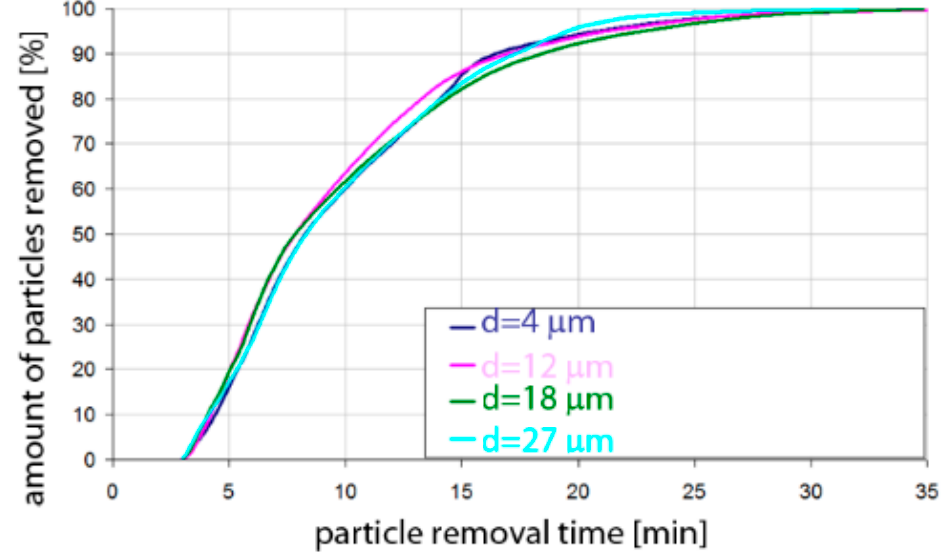
Figure 21. Share of removed non-metallic Al 2 O 3 inclusions from the analysed ladle in the case of argon flow of 50 L/min through the 42CrMo4 steel.